Question: What type of chart is this?
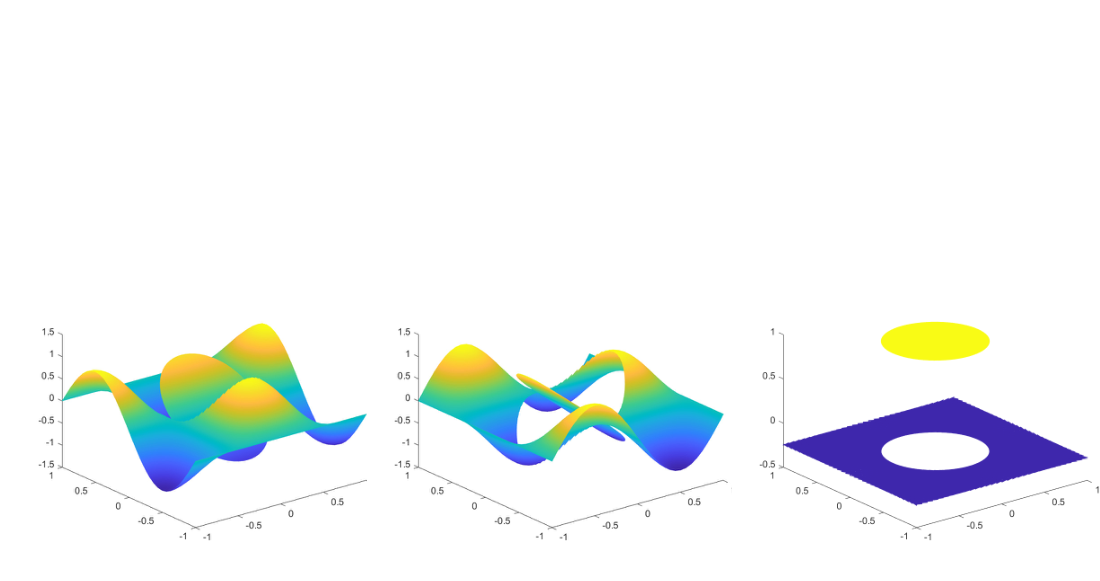
Answer: line